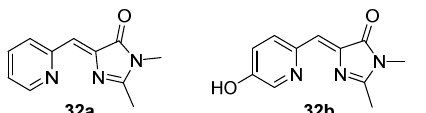
Figure 30. GFPc analogues with an increased emission intensity when complexed with Zn (II)